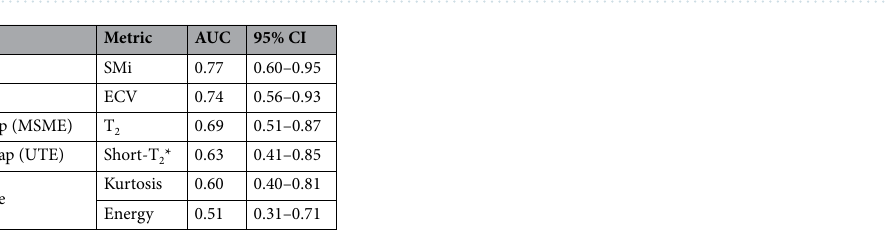
Figure 6. Increased stiffness in fibrotic skeletal muscle. ( a ) Boxplots showing that ankle plantar flexion increases the shear-wave modulus in both injured and control muscles, from C57BL/6 and DBA/2J mice, but no difference between injured and control muscles could be detected (Supplementary Table S4). ( b ) The viscoelastic index was higher in injured muscles and ( c ) correlated with collagen fraction, indicating that muscle stiffness is increased in fibrotic muscles and that it can be detected non-invasively with SWE. Lines connect injured and control muscles for each mouse in ( b ). ( c ) Scatter plot with fitted linear regression and 95% confidence interval in grey.